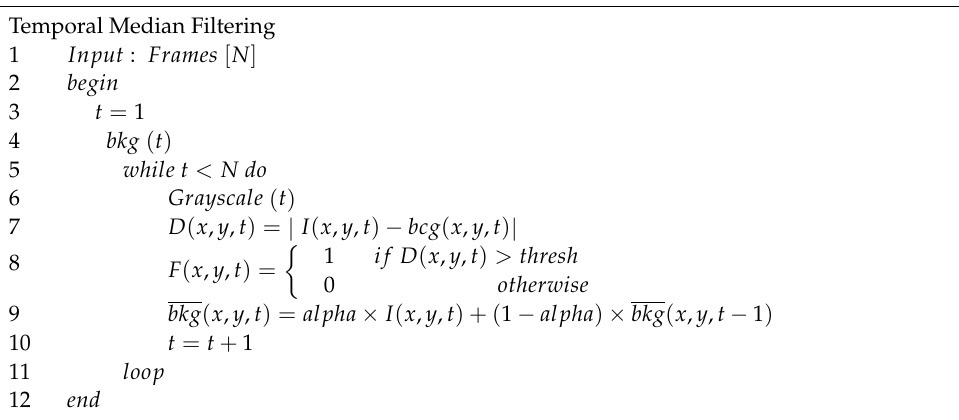
Algorithm 2. Temporal Median Filtering Algorithm. Algorithm 2 Temporal Median Filtering